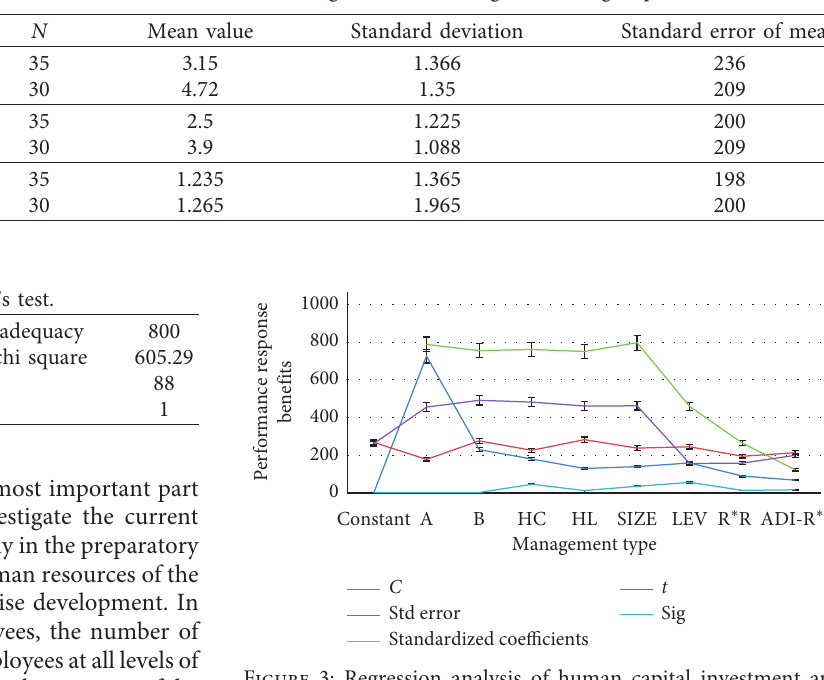
Figure 2: The average value of the high and low groups. Table 2: Comparison of the standard deviation of the average value of the high and low groups.